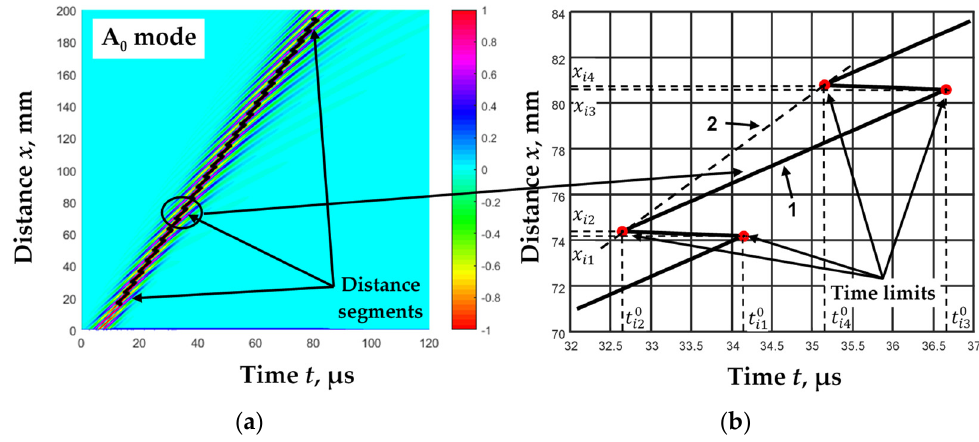
Figure 3. Calculated zero-crossing instances (line) with simulated Lamb wave A 0 mode signals (color-coded) ( a ) and zero-crossing instances of the i -th filter in the narrow range ( b ).